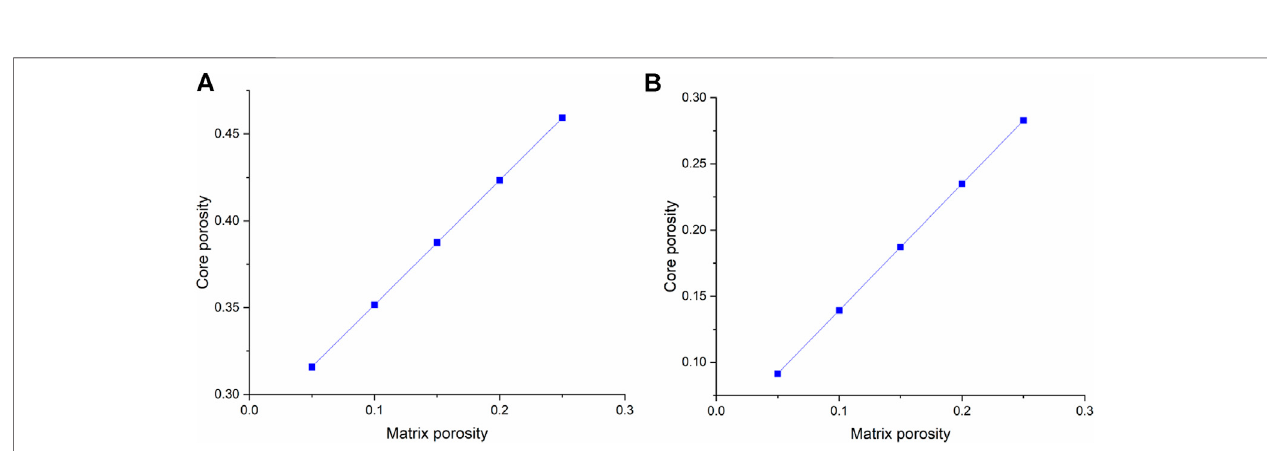
FIGURE 13 | Effect of matrix porosity on core porosity: (A) vugular carbonate rock and (B) isolated vug carbonate rock.